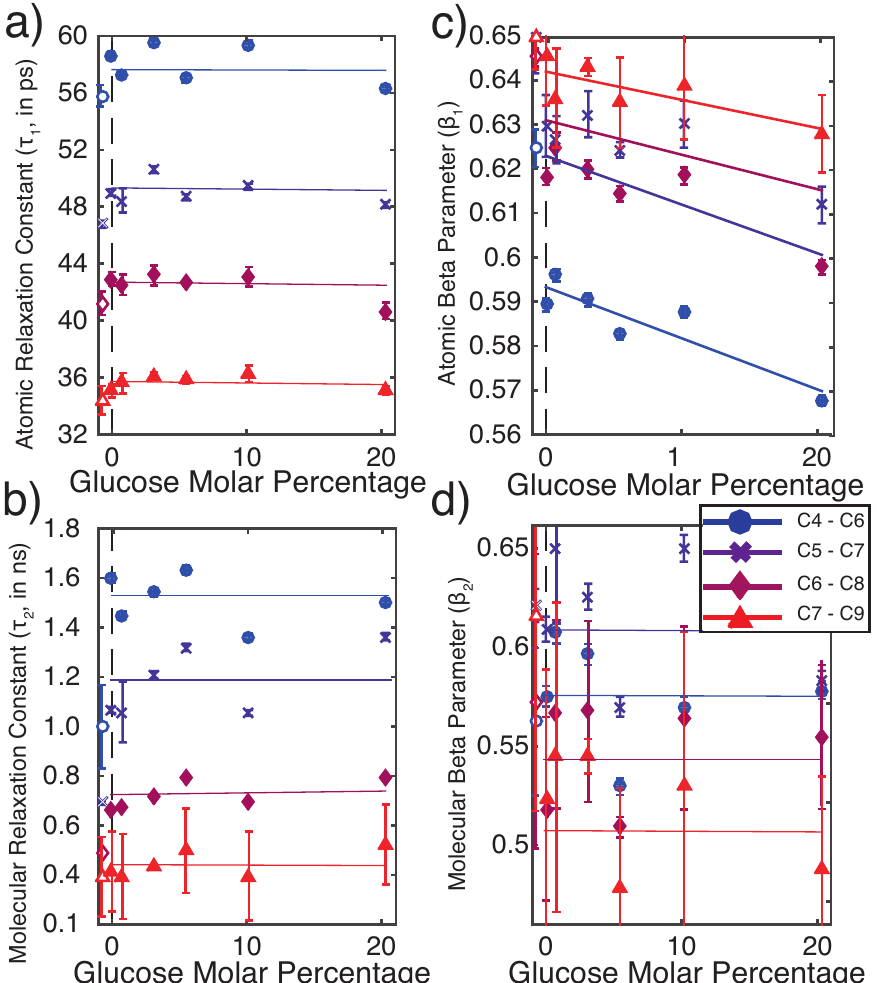
Figure 6. Parameters determined from fits of two stretched exponentials to the autocorrelation function. Windows 4–7 are displayed for analysis as these windows yielded least variable fits. Values below 0 with hollowed markers correspond to fully hydrated membrane system. Atomic time constant, τ 1 ( a ), and molecular time constant, τ 2 ( b ), are independent of glucose concentration and decrease towards the tails. ( c ) Atomic stretching exponent, β 1 , decreases with sugar concentration and increases towards tails while the molecular stretching exponent, β 2 , ( d ) is independent of both sugar concentration and carbon